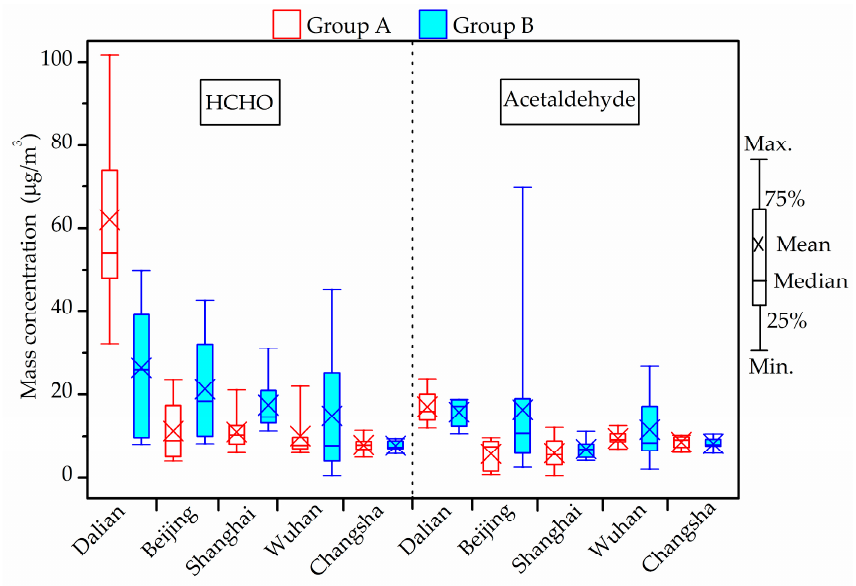
Figure 3. Indoor formaldehyde (HCHO) and acetaldehyde concentrations in winter.